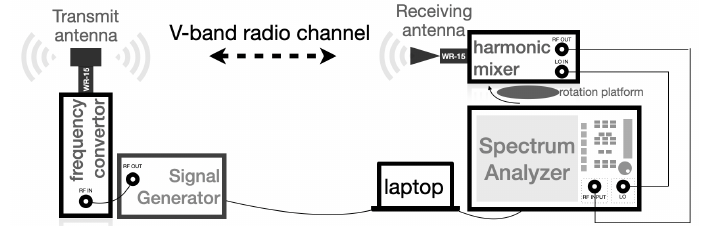
Figure 1. V-band channel sounding